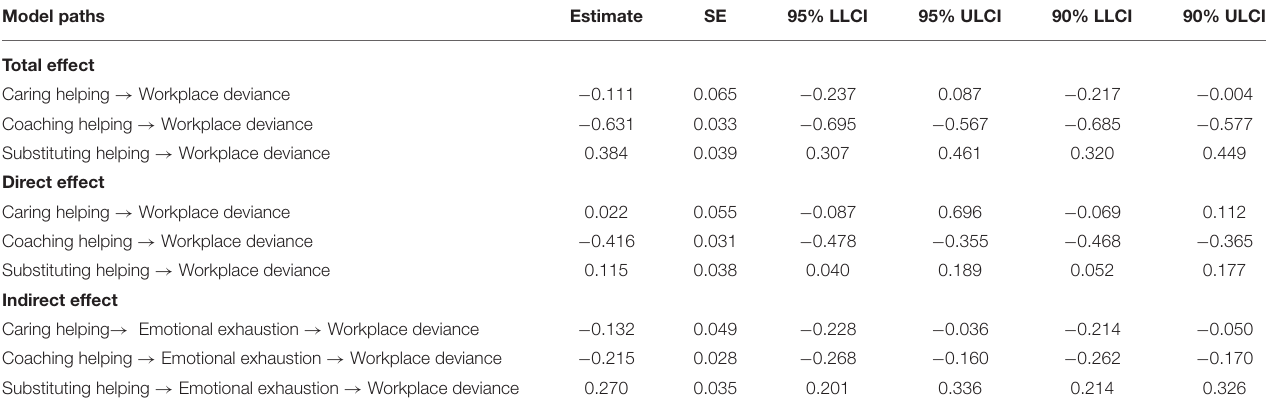
TABLE 4 | Standardized mediation analysis